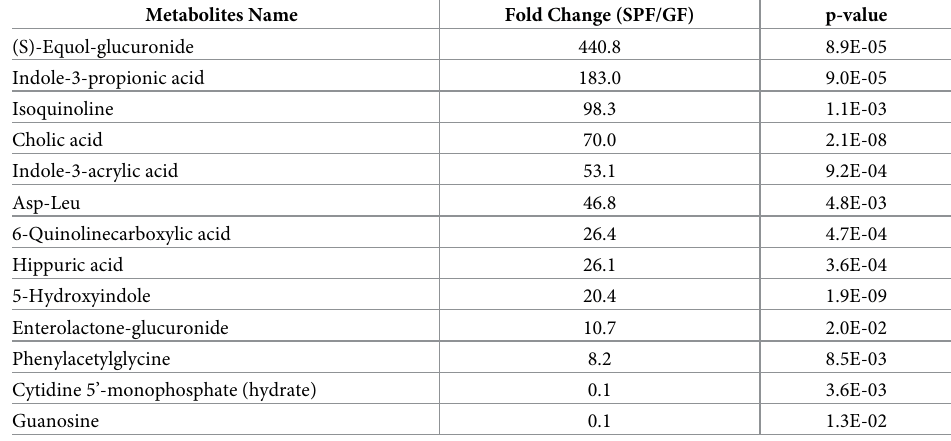
Table 2. Significantly transformed compounds in serum from 13 week-old ApoE -/-